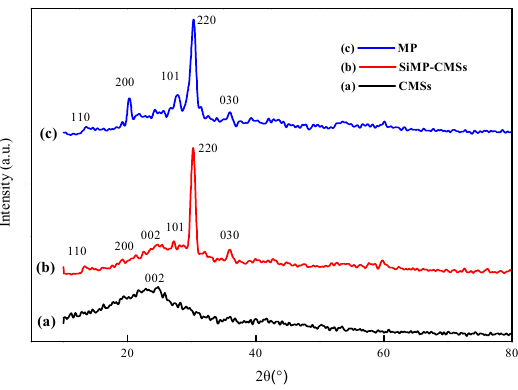
Figure 4. X-Ray diffraction (XRD) spectrum of CMSs ( a ), SiMP-CMSs ( b ) and MP ( c ).